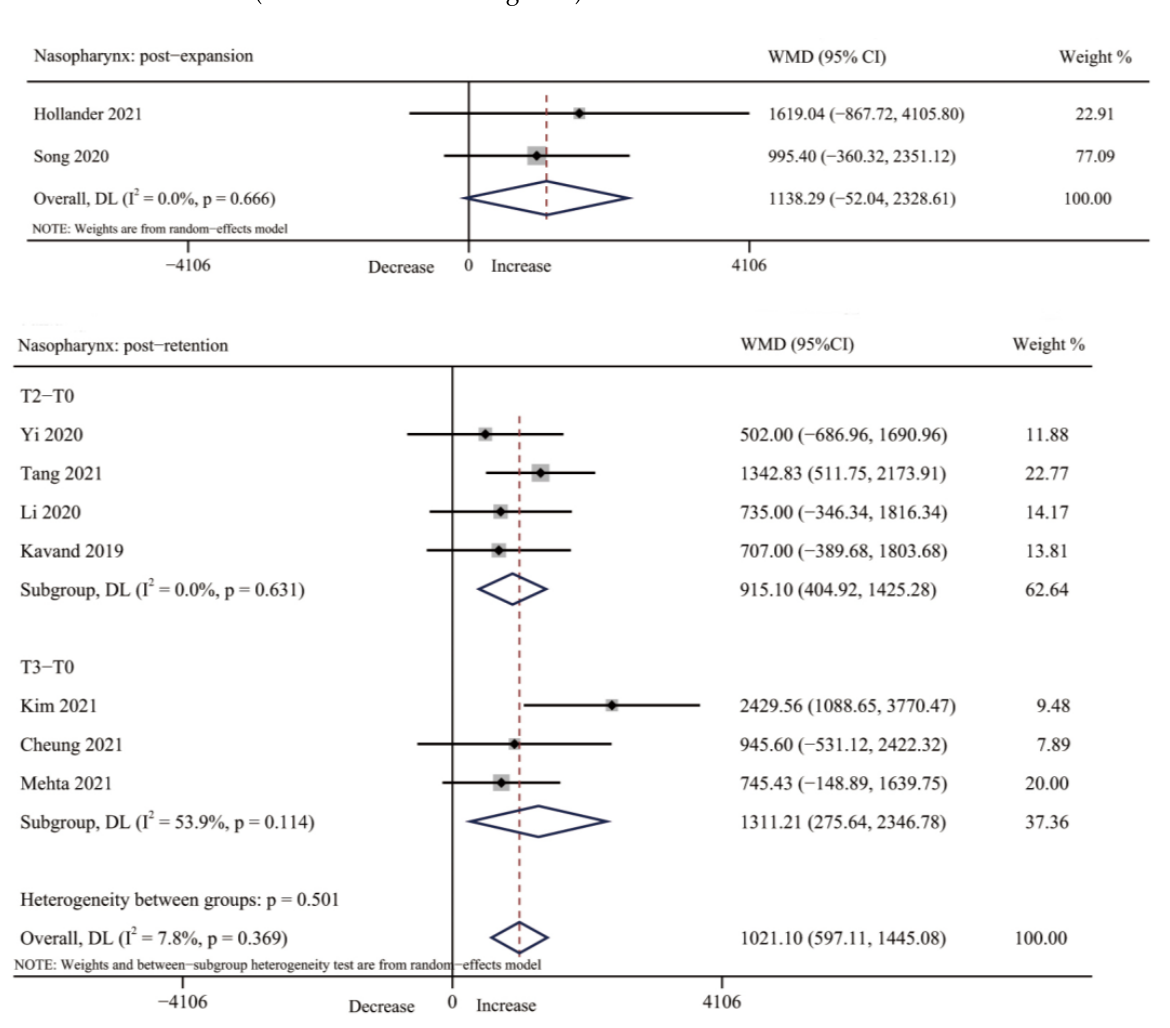
Figure 5. Forest plot for the changes of nasopharynx volume immediately after expansion (T1) and retention (T2-T3). T0, before expansion; T1, immediately after expansion; T2, three months after ex- pansion; T3, six months after expansion; WMD, weighted mean difference; CI, confidence interval [32,34,35,37 – 42].